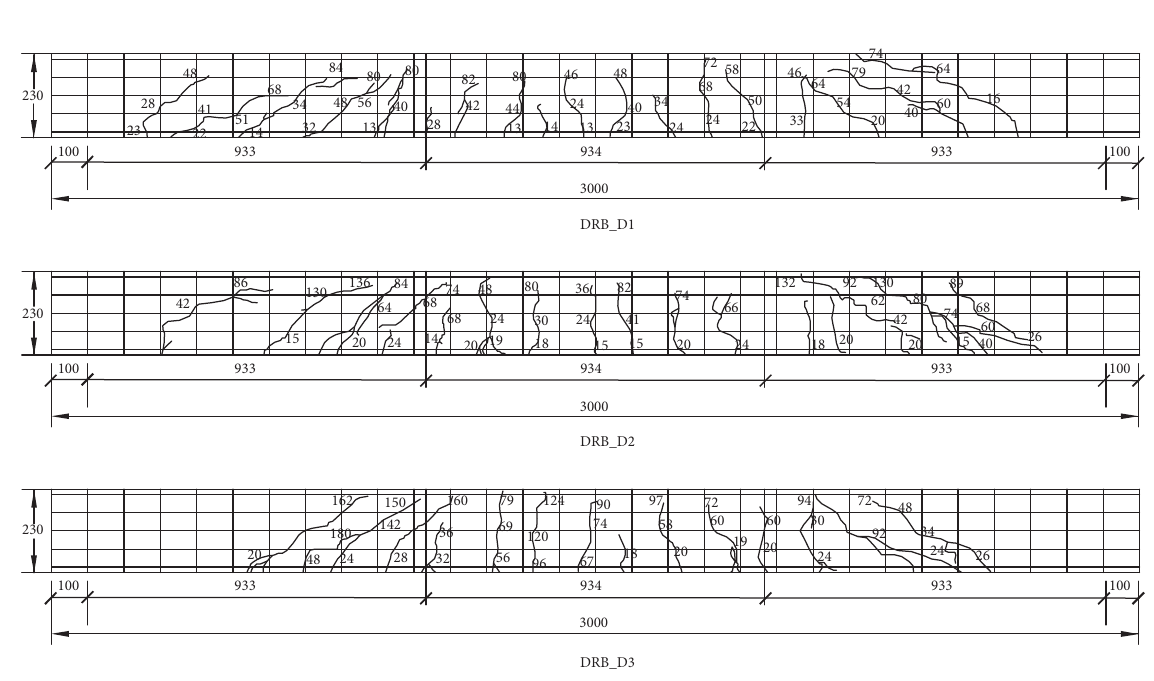
Figure 10: The crack pattern of GPCC for doubly reinforced beam